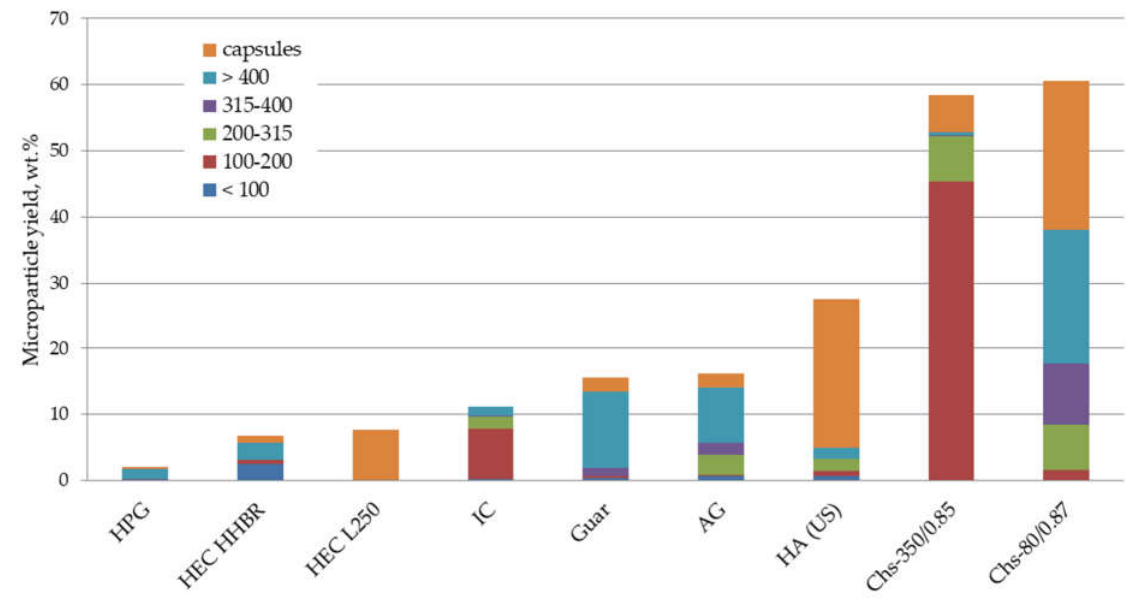
Figure 1. Total yield and size distribution of PLA microparticles stabilized with various polysaccharides in the course of their fabrication via the oil/water solvent evaporation technique. The legend shows a size range (µm) of microparticle fractions.